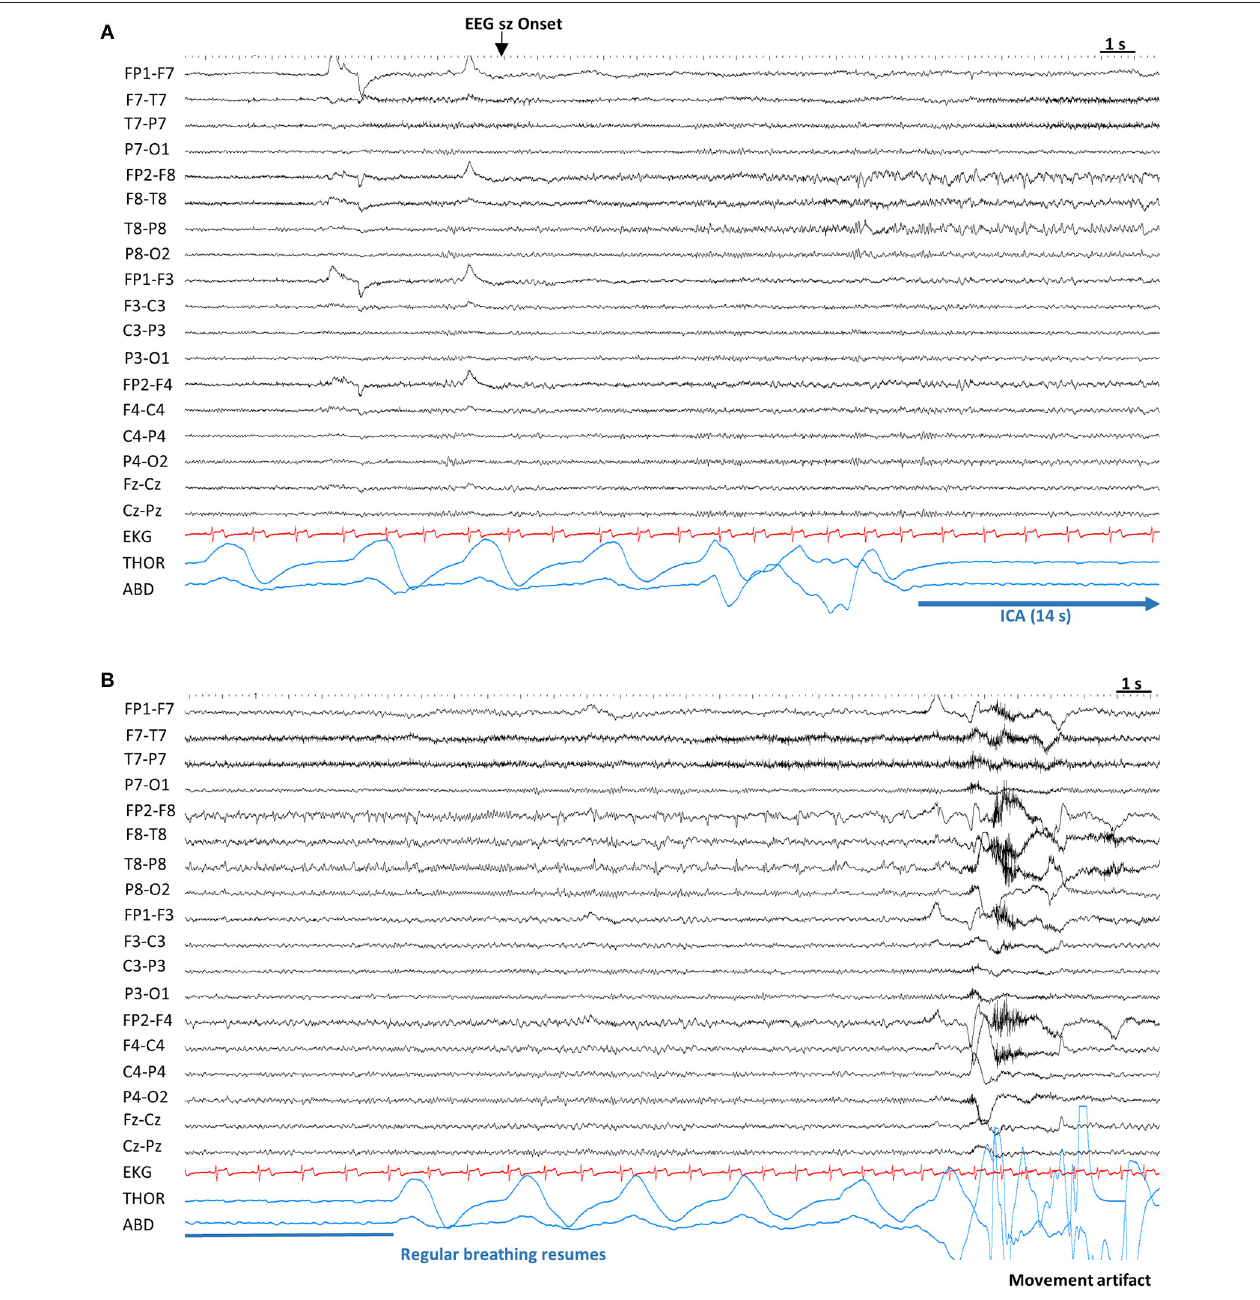
FIGURE 2 | Example of ictal central apnea (ICA). Sensitivity 7 µ V, High Frequency Filter: 70Hz, Time constant: 0.1s. (A) Twelve seconds after the electrographic onset, ICA is noted without any other clinical signs. (B) Continuation of ICA, with a total duration of 14s, followed by breathing resumption. ABD, abdominal; EEG sz onset, electrographic seizure onset; EKG, electrocardiogram; ICA, Ictal central apnea; s, seconds; THOR,